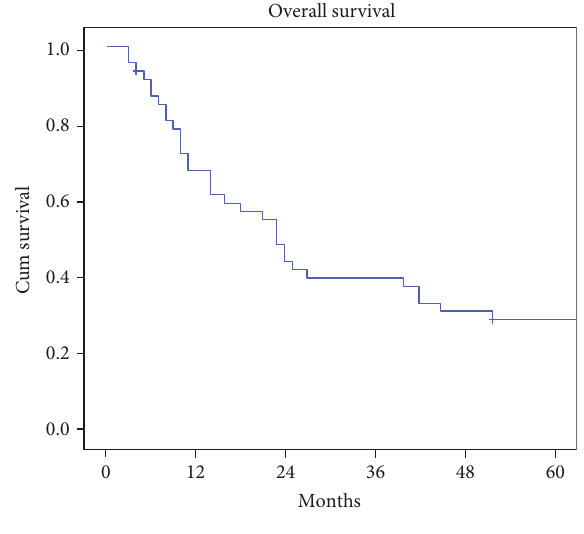
Figure 2: Overall